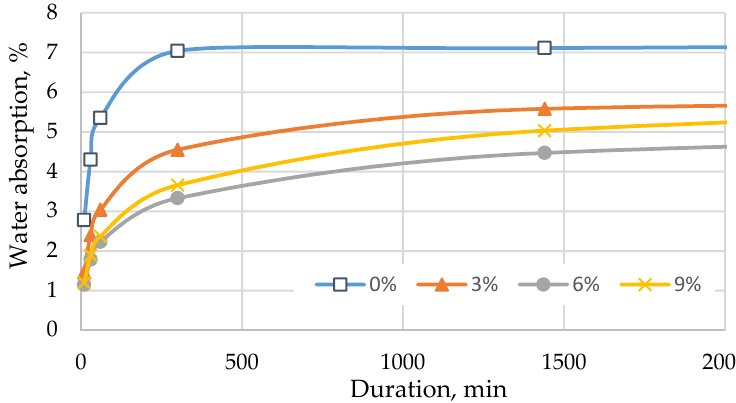
Materials 2019 , 12 , x FOR PEER REVIEW Figure 9. Water absorption when a part of sand is replaced with TS. Figure 9. Water absorption when a part of sand is replaced with TS. Figure 9. Water absorption when a part of sand is replaced with TS.